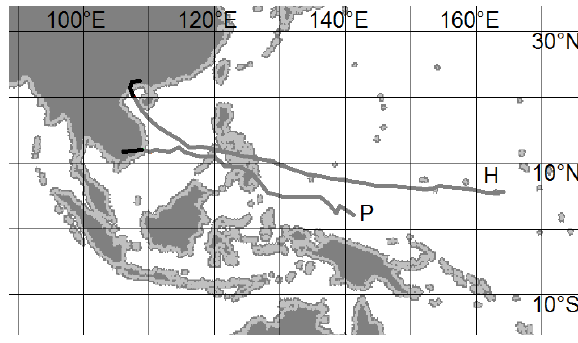
Figure 7. Tracks of the TC Haiyan (H) and the TS Podul (P)